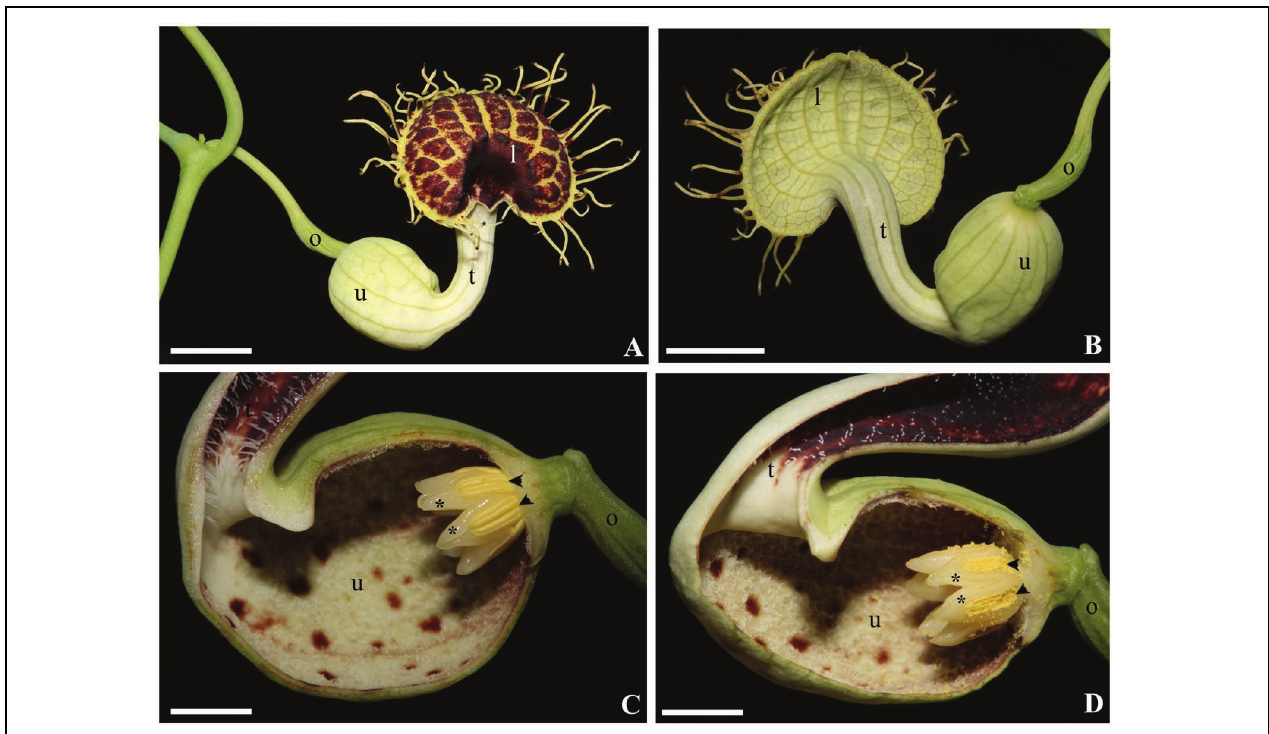
FIGURE 1 | Aristolochia fimbriata . Anthetic flower in face (A) and back (B) view. Close-up of the gynostemium in female (C) and male (D) phases. Black arrowheads indicate anthers; asterisks ( ∗ ) indicate the upper portion of a single carpel alternating with each anther; l, limb; o, ovary; t, tube; u, utricle. Scale bar: 1 cm.